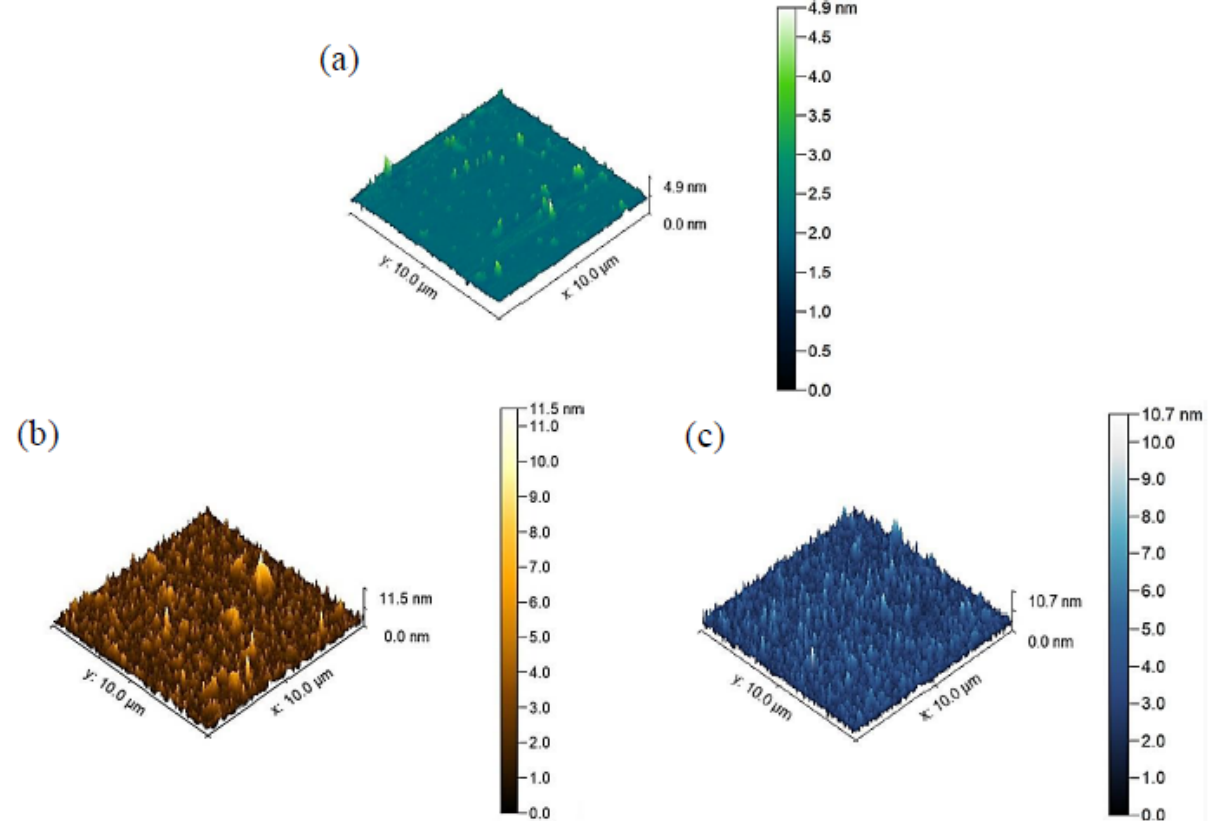
Figure 1. Three-dimensional topographies of the ( a ) uncoated silicon surface, ( b ) gold surface, and ( c ) silver surface from Gwyddion software (version 2.59).